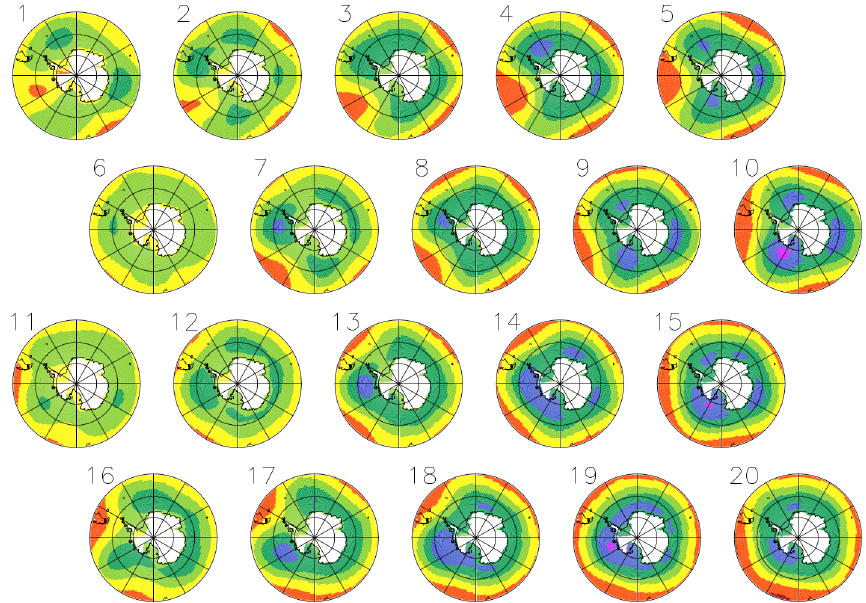
Figure 2. Mean sea-level pressure (SLP) map for the 20 best-matching units (BMUs) obtained after a self-organizing map analysis on daily SLP fields. SLP ranges from 1030hPa (red) to 960hPa (purple) with 10hPa intervals.